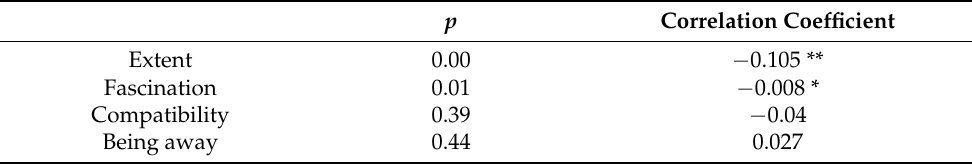
Table 7. Correlations among the four dimensions and the five timings restoration